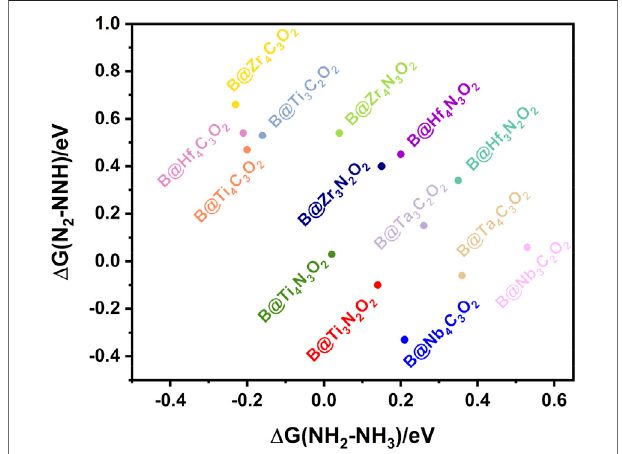
Frontiers in Chemical Engineering |